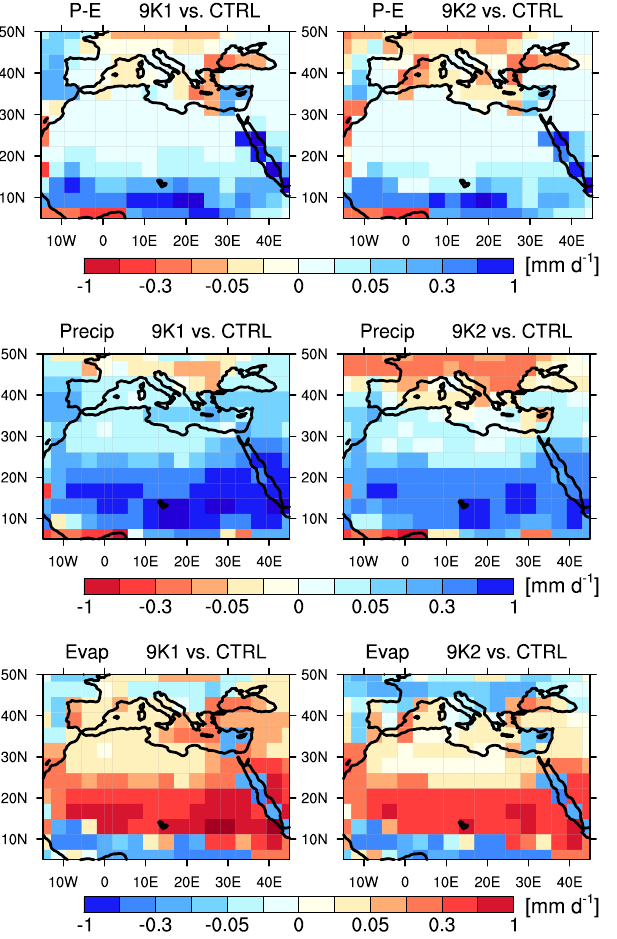
Fig. 8. Annual mean anomalies of P - E , P and E from global sim- ulations, 9K1 vs. CTRL (left) and 9K2 vs. CTRL (right).